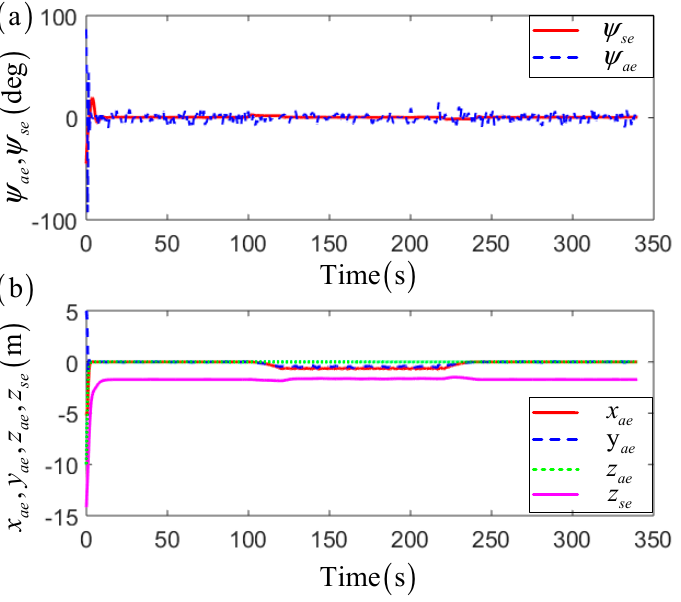
Figure 8. The position and heading errors for the USV-UAV (( a ) is heading errors for USV-UAV. ( b ) is position errors for USV-UAV.).